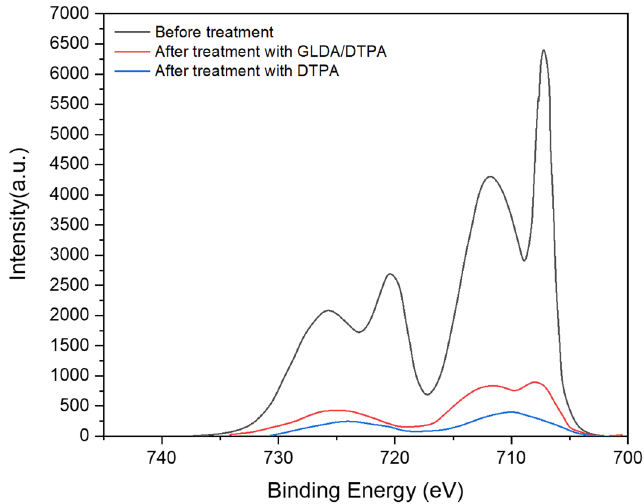
Figure 12. XPS results for pyrite surface before and after treatment with slightly acidic (pH 6.77) DTPA/GLDA formulation and DTPA alone basic formulation (pH 13).